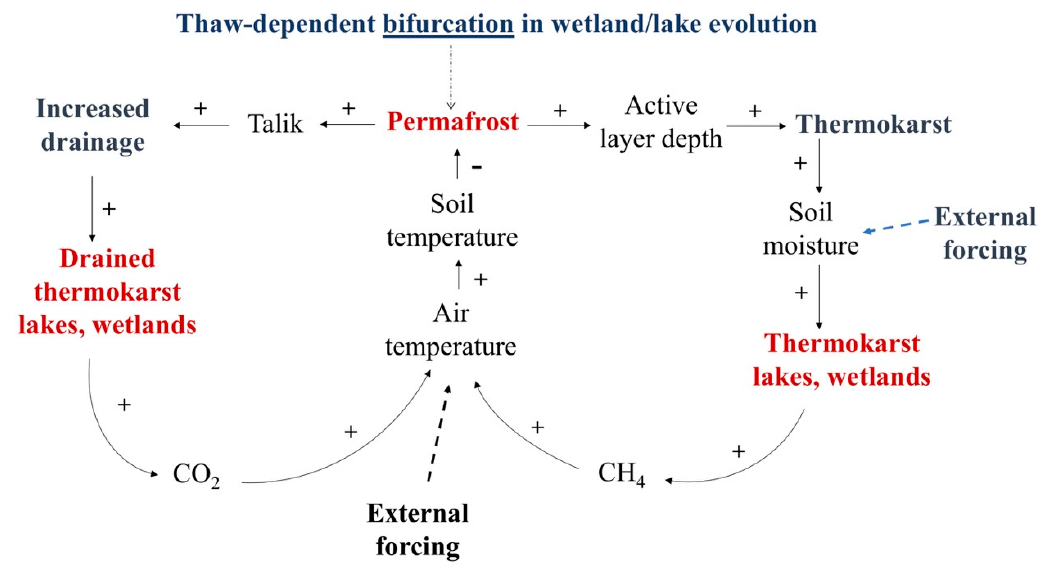
Figure 1. System diagram for permafrost-related regime shifts: (right loop) from terrestrial to aquatic thermokarst wetland/lake ecosystems, and (left loop) vice versa. Plus and minus signs indicate positive and negative relationships, respectively. This diagram is constructed based on corresponding system diagrams in [4].